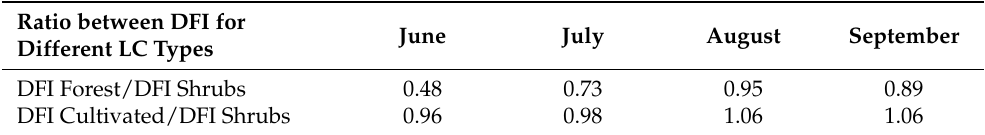
Table 3. Ratios of the monthly accumulated DFI of forest and cultivated LC fires to the DFI of shrubs fires for the period of 2007–2018.